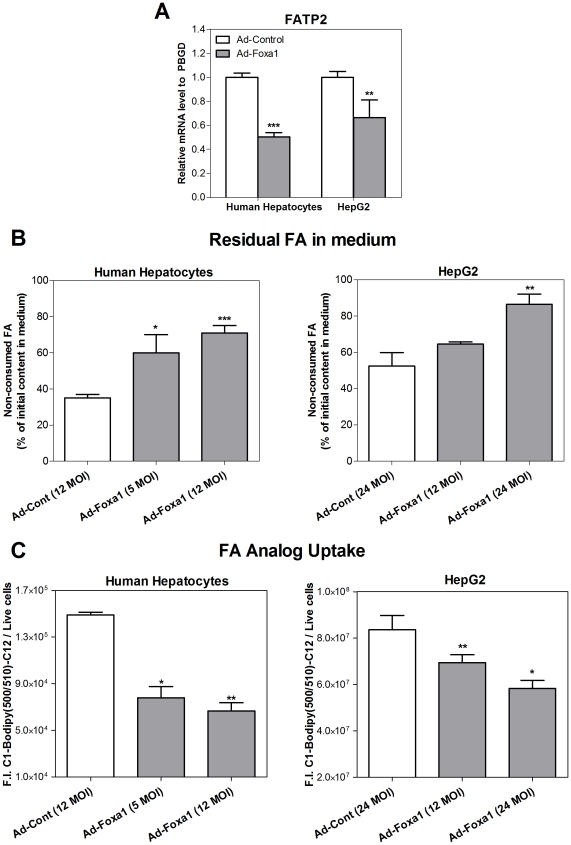
Foxa1 decreases FA uptake.(A) Cultured cells were infected with Ad-Foxa1 or Ad-Control for 48h, and the mRNA level of the plasma membrane fatty acid transporter protein 2 (FATP2) was measured by real-time Q-RT-PCR. (B) Human hepatocytes and HepG2 cells were infected with Ad-Foxa1 for 24h and were then exposed to 0.2 mM FA (oleate: palmitate, 2∶1) for an additional period lasting 16 h. The amount of non-consumed (residual) free FA, expressed as the percentage of the initial amount in the culture medium, were determined with a specific kit. (C) The uptake of a fluorescent FA analog (C1-BODIPY 500/510-C12) was measured in HepG2 cells and human cultured hepatocytes with an Olympus ScanR Screening Station. Data represent the mean±SD of 4–5 independent experiments. * p<0.05; ** p<0.01; *** p<0.001 in relation to Ad-Control infected cells.